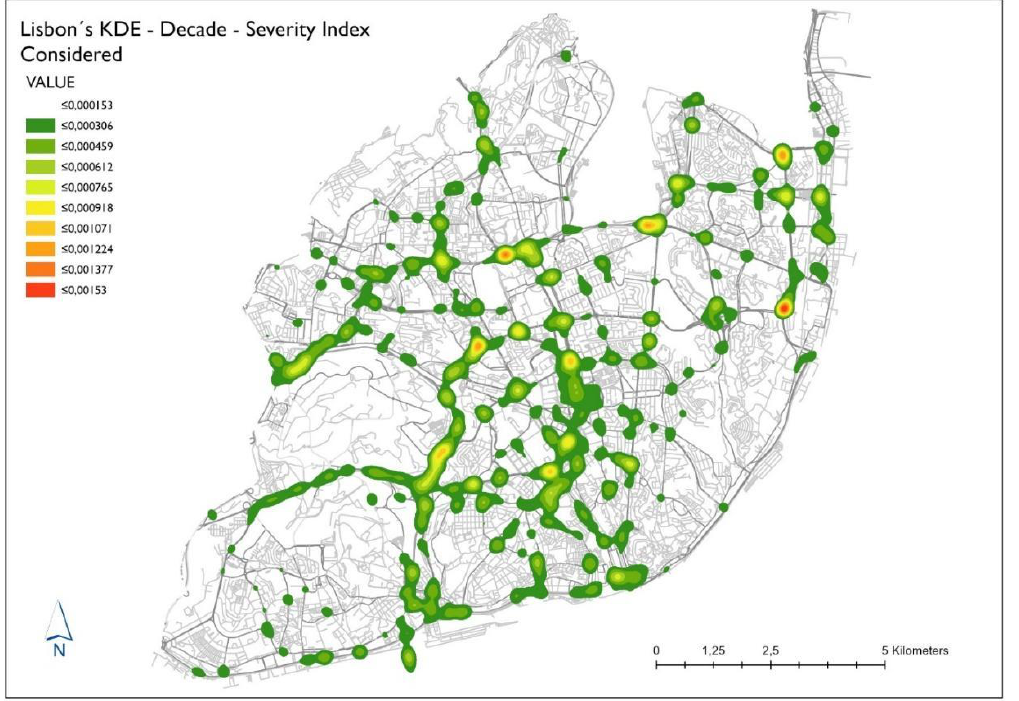
Figure 3. KDE analysis decade analysis 2010 – 2019 in Lisboa city with an area of 100 m 2